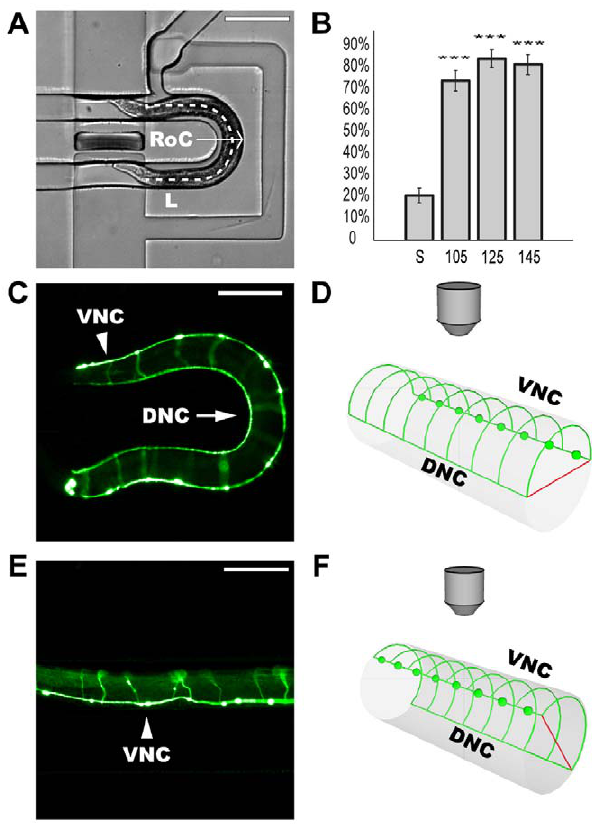
Figure 2. Effect of curved channel on animal orientation. (A) Zoomed in view of imaging area shown by dashed red box from Figure 1A. White arrow indicates device radius of curvature (RoC) from arc center to outer edge. Dashed line indicates length (L) between loading and imaging valves. Scale bar is 200 m m. (B) Frequency of lateral nematode orientation for various channel geometries with standard error of proportion. Triple asterisk indicates statistical significance compared to straight channel designs ( p , 0.001 determined using chi- squared test). S represents straight channel, while remaining labels indicate the 105 m m, 125 m m, and 145 m m RoC devices respectively. L for all devices is 700 m m. (C) Nematode oriented laterally in curved channel device (both nerve cords visible). Commissures present on different focal plane are obscured. (D) 3-D model of animal body section and microscope objective (viewpoint reference) showing nerve cord placement for a laterally oriented animal. (E) Nematode in a non- lateral body orientation as observed when loading animals into straight channel devices; DNC not visible due to animal orientation. Animal is within the same field of view as seen in panel C. Arrowheads for images (C) and (E) indicate ventral nerve cord (VNC) determined by placement of VD and DD motor neuron cell bodies. Arrow indicates dorsal nerve cord (DNC). Scale bars are 100 m m. Transgene marker for all fluorescent images is juIs76(Punc-25::GFP ). (F) 3-D model of animal body section and microscope objective for non-lateral oriented animal. Model diagrams (D) and (F) not drawn to scale. Red lines illustrate dorso-ventral axis. Green spheres represent DD and VD neuron cell bodies.